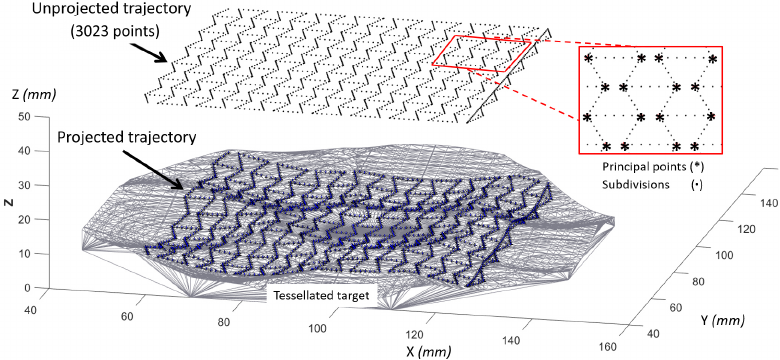
Figure 15. Simulation of the re-entrant pattern projected on an arbitrary tessellated surface.